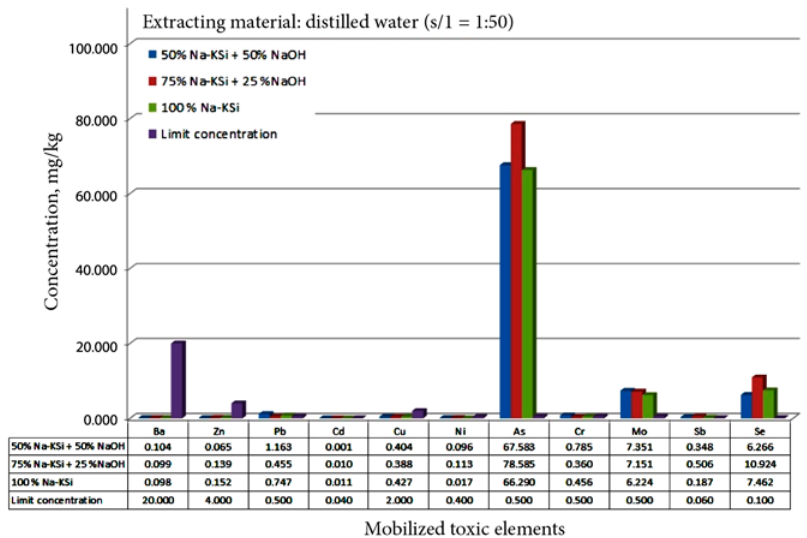
Fig. 11. Quantity of mobilized toxic elements from 10 days age geopolymers using distilled water as extracting material (solid/liquid ratio